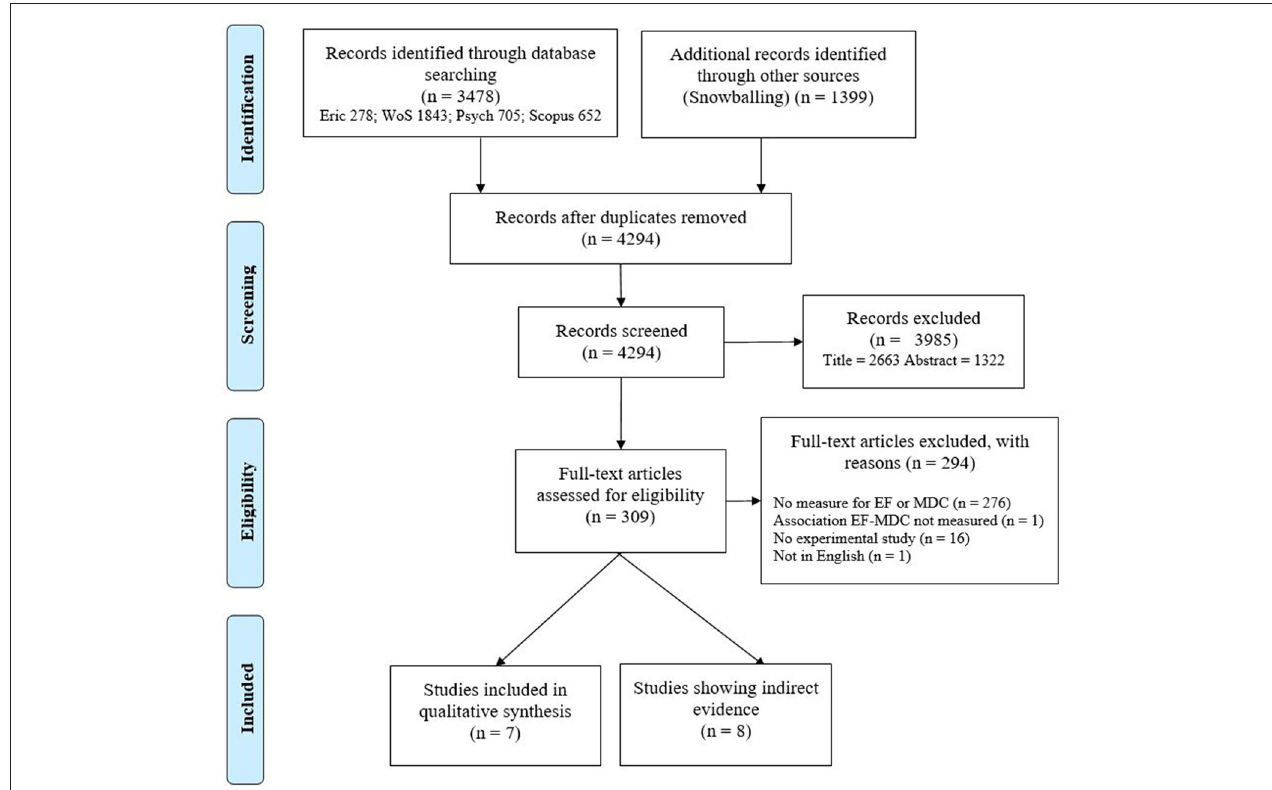
FIGURE 1 | PRISMA flow